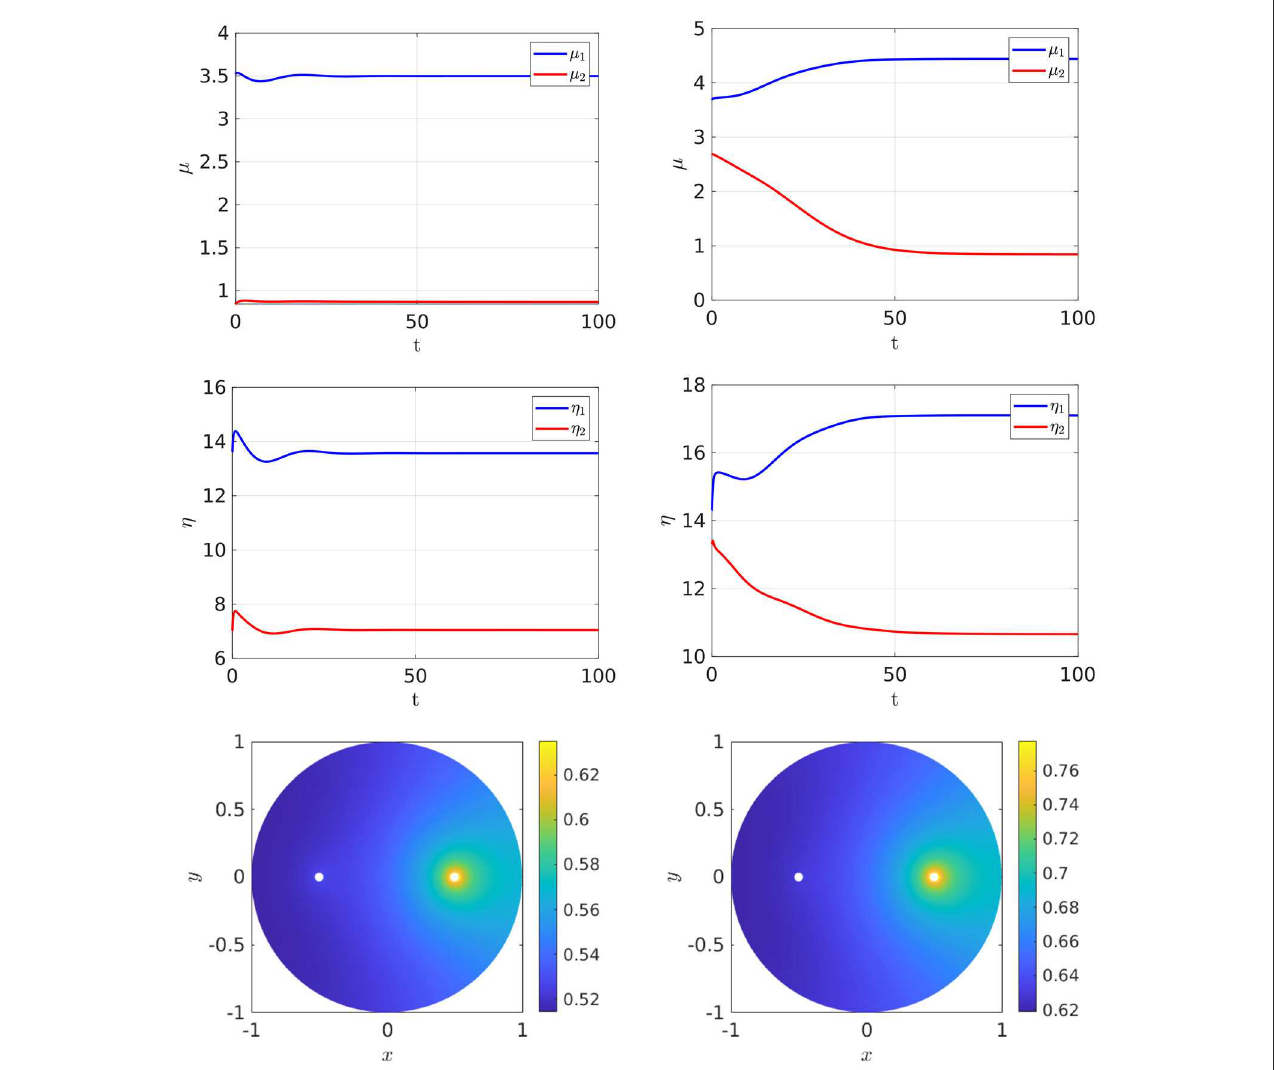
FIGURE7 Full numerical simulation results of Equation (2.3) with FlexPDE [50] for GM kinetics (Equation 4.3). Left: convergence to the asymmetric branch for an initial condition near this branch when ρ 7.2 lies in the hysteresis region between the fold point ρ s = 7.70971. Right: convergence to an asymmetric steady-state as selected by a small initial perturbation of the symmetric solution in the direction ρ p ≈ q 2 (1, 1) when ρ 15 > ρ p . The bottom panels show the concentration of u . Parameters: D u = − =